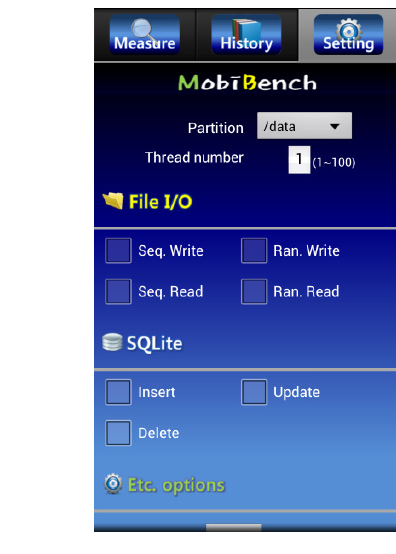
Figure 2. Mobibench application. ( a ) Measure tab; ( b ) Setting